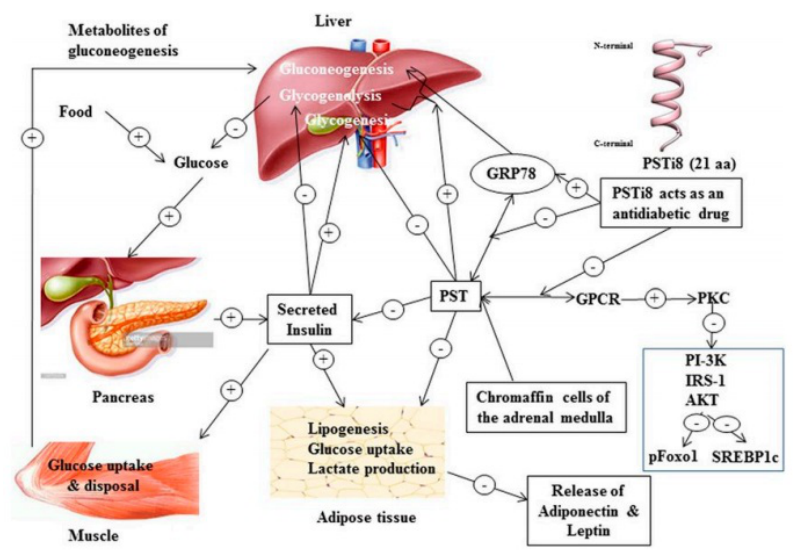
Fig. 4 Energy Consumption before and after Baduanjin and Ninth Broadcast